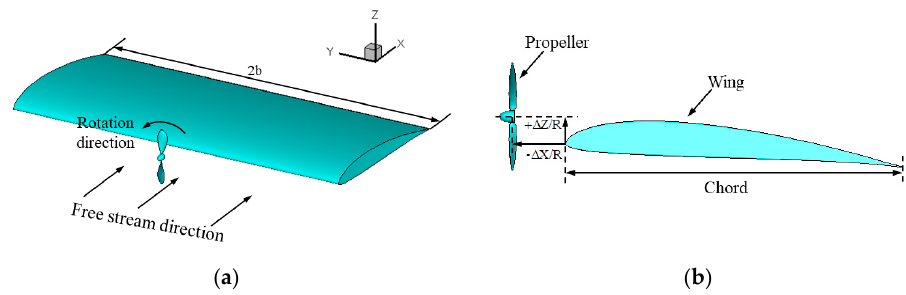
Figure 4. A tractor propeller ‐ wing configuration: ( a ) Oblique view; ( b ) side view.